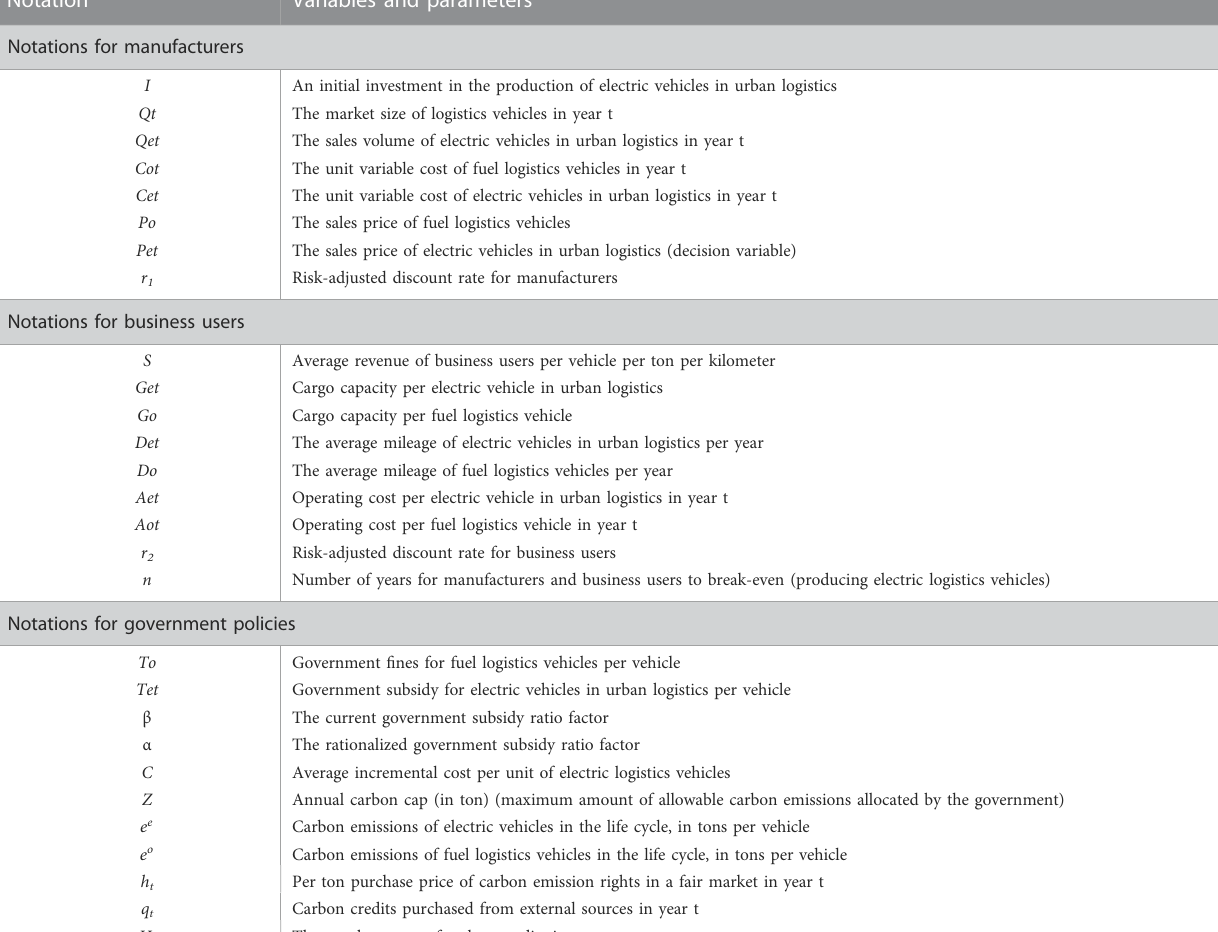
TABLE 1 Variables and